Question: Describe this figure in one sentence.
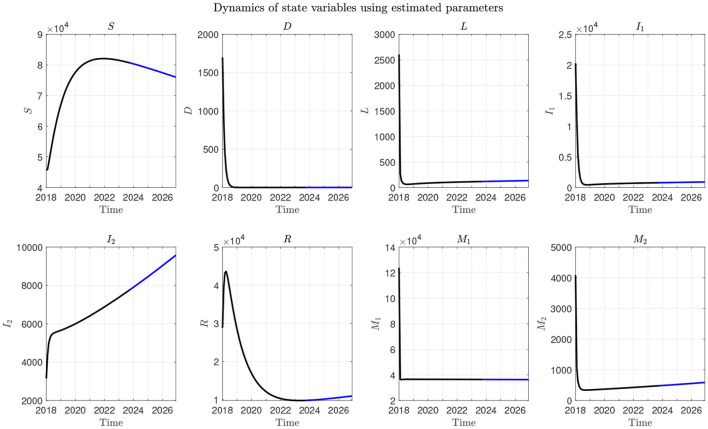
Answer: Model output of system Equation 12 using the estimated parameter values. The black curve represents the model output before November 2023, while the blue curve shows the extension up to December 2026.